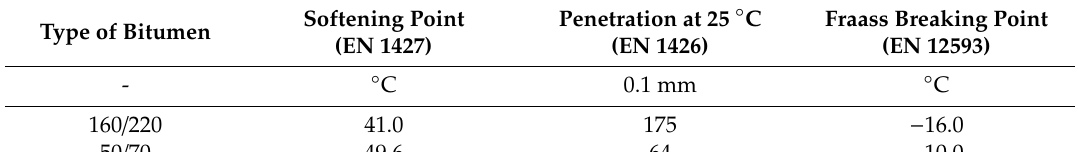
Table 1. Properties of the base bitumens.